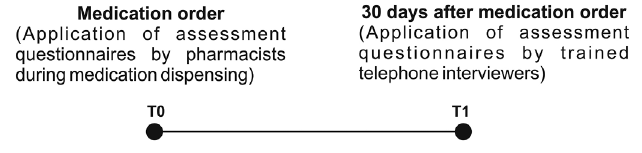
FIGURE 3 - Assessment timepoints of patient knowledge of medication in the evaluation of the dispensing